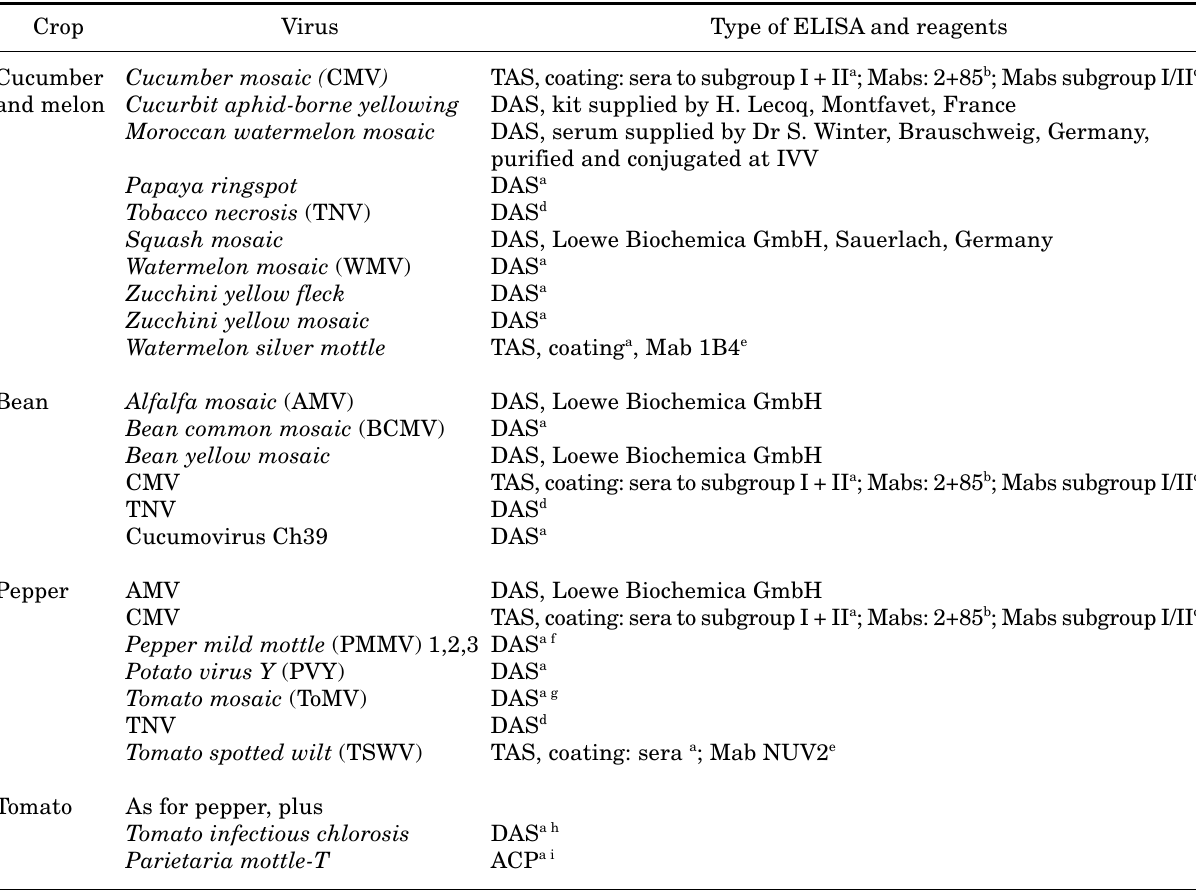
Table 1. Antisera or antibodies used to detect viruses by ELISA in the original desiccated samples. Crop Virus Type of ELISA and